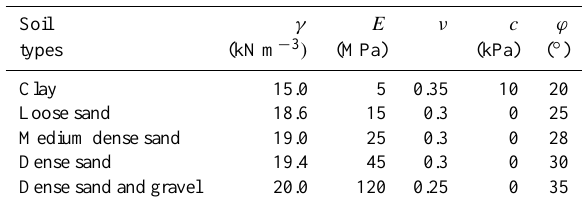
Table 4. Mechanical characteristics of soils used in numerical anal- ysis.